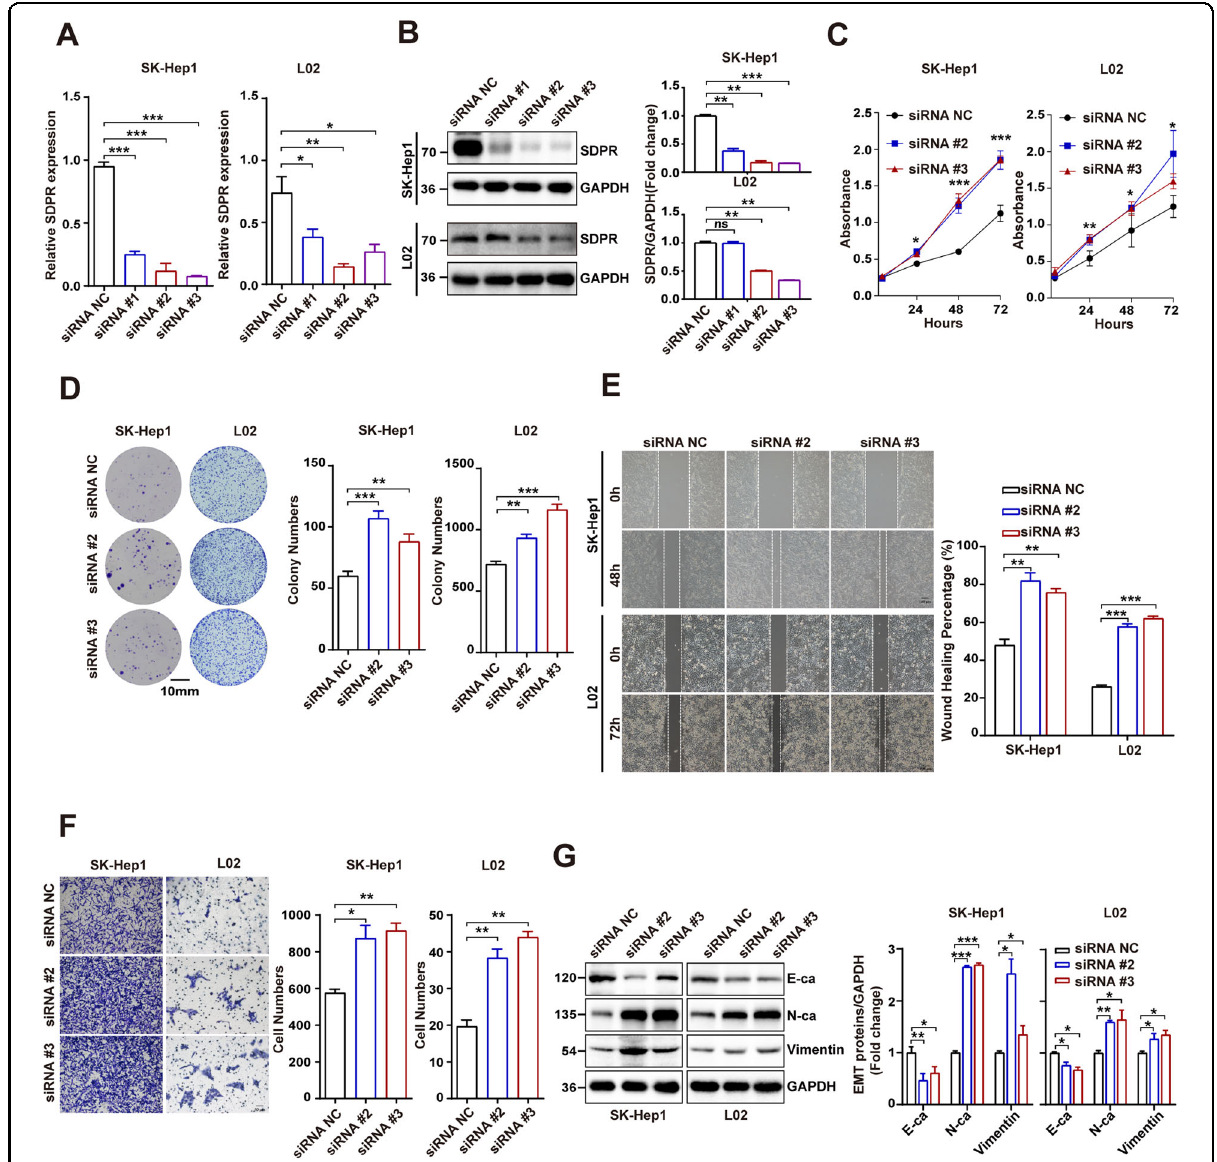
Fig. 3 Depletion of SDPR promoted cell proliferation, migration, and invasion of SK-Hep1 and L02 cells. A , B SDPR knockdown ef fi ciency was identi fi ed by western blotting and qRT-PCR. C , D CCK-8, and colony formation assays showed that SDPR knockdown facilitated SK-Hep1 and L02 cells growth. E , F Depletion of SDPR promoted cell invasion and migration by transwell and wound-healing assays. G The EMT proteins level of E-cadherin (E-Ca), N-cadherin (N-Ca), and vimentin in SDPR depleted SK-Hep1 and L02 cell lines. * p < 0.05; *** p < 0.01; *** p <